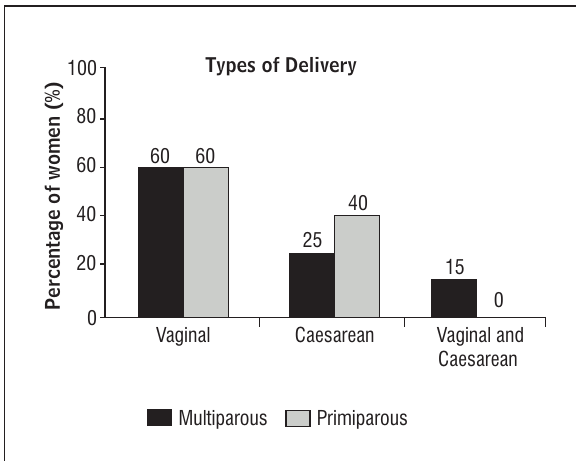
Figure 1 - Graphic representation of the type of delivery carried out by the women assessed —